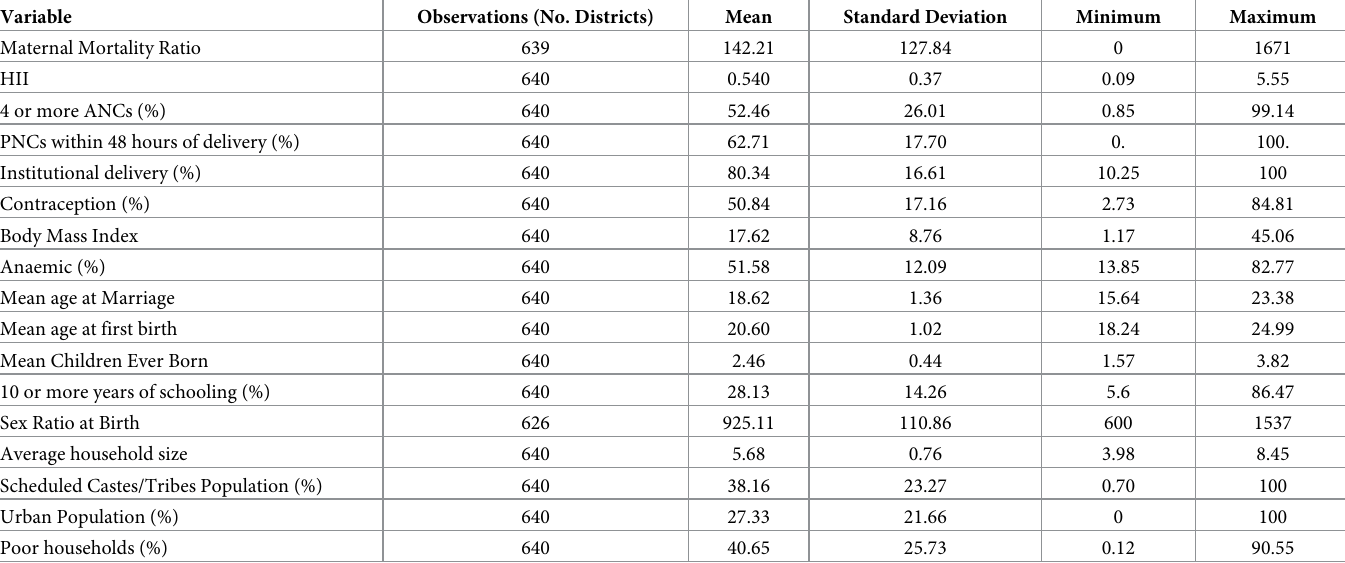
Table 2. Descriptive statistics of the study